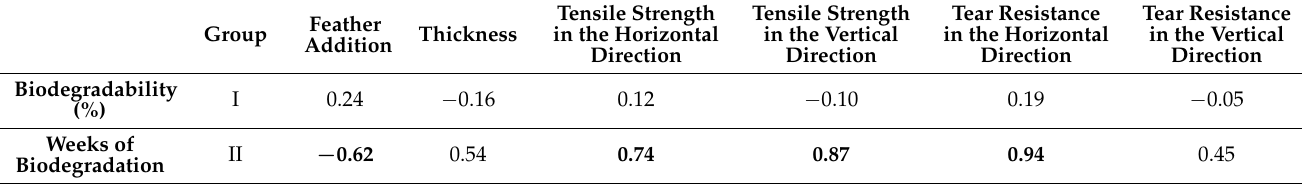
Table 5. The relationships between the metrological parameters and the biodegradability/biodegradation times of samples in Groups I and II (correlation matrix; correlation